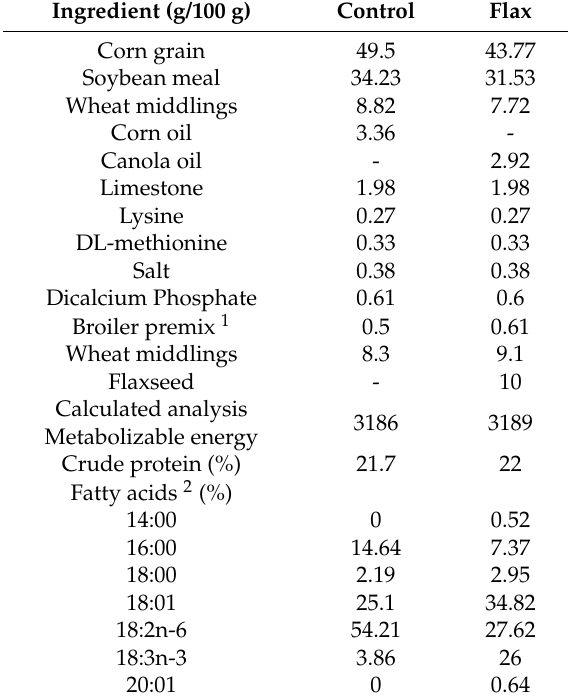
Ingredient content, fatty acid composition and calculated nutrient analysis of experimental